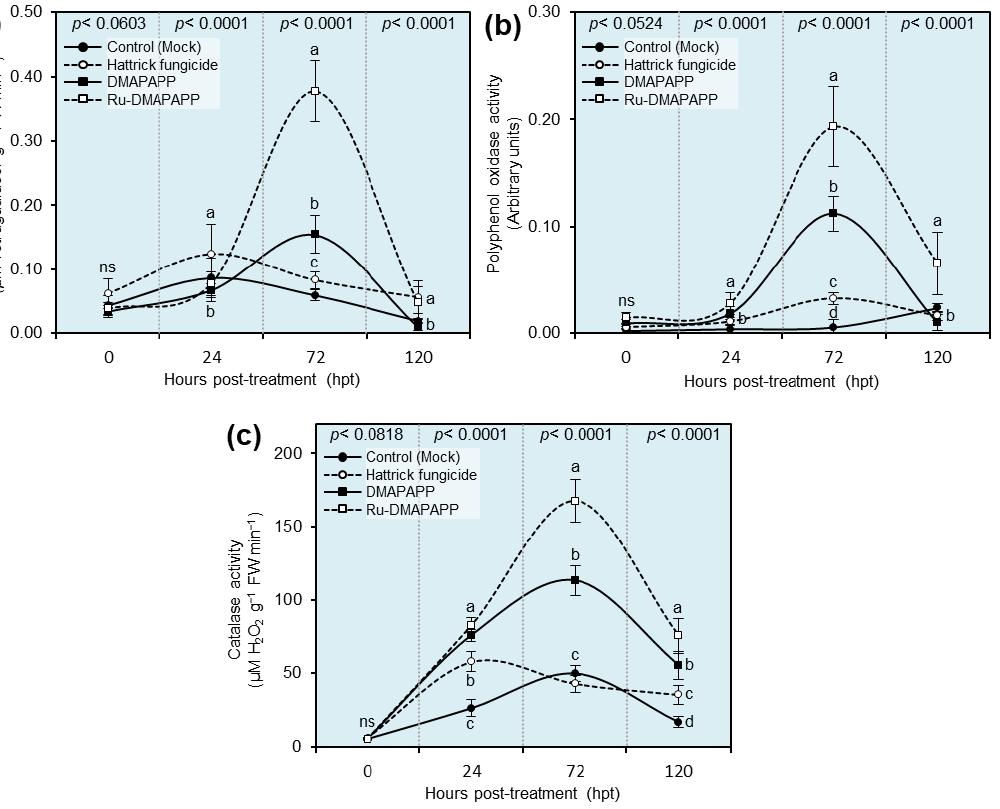
Figure 7. Effect of two bis-chalcone derivatives, DMAPAPP or Ru-DMAPAPP, on the enzymatic activity of the major antioxidant defense-related enzymes associated with fusarium wilt disease caused by Fusarium equiseti on pepper plants under greenhouse conditions. ( a ) Peroxidase activity (μM tetraguaiacol g −1 FW min −1 ), ( b ) polyphenol oxidase activity (arbitrary units), and ( c ) catalase activity (μM H 2 O 2 g −1 FW min −1 ). Values represent the means ± standard deviations (means ± SD). Different letters indicate statistically significant differences between treatments using the Tukey – Kramer honestly significant difference test (Tukey HSD; p < 0.05).